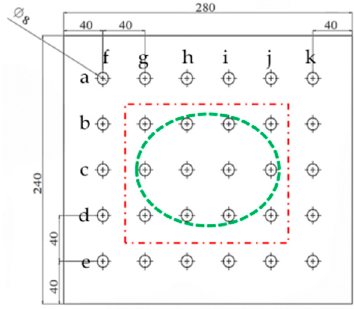
Figure 24. Effective area division of the microwave-irradiated soil surface.